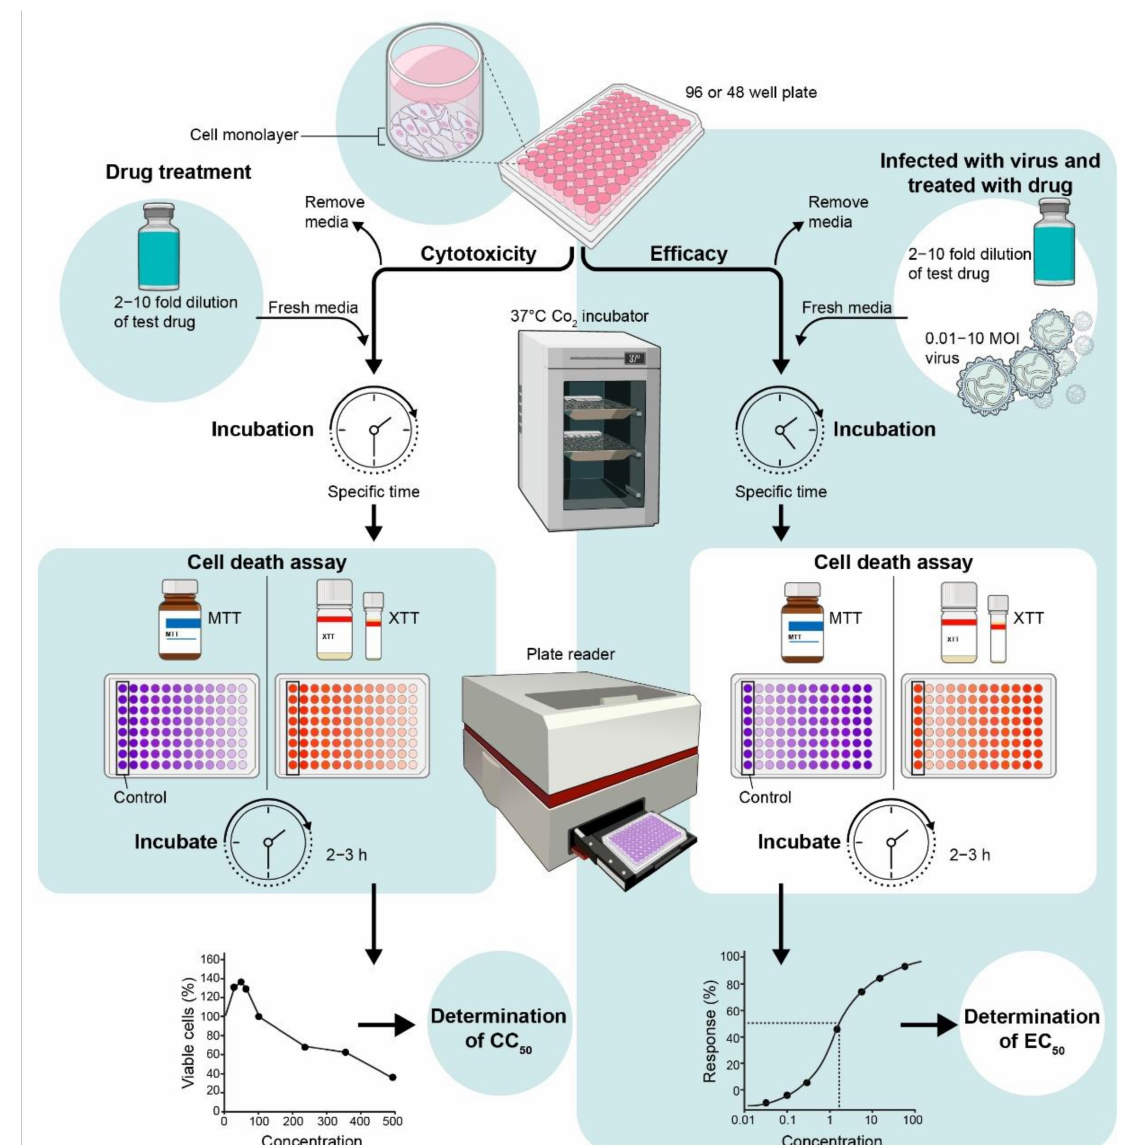
Figure 2. Schematic diagram of screening for drug activity against virus-induced cell